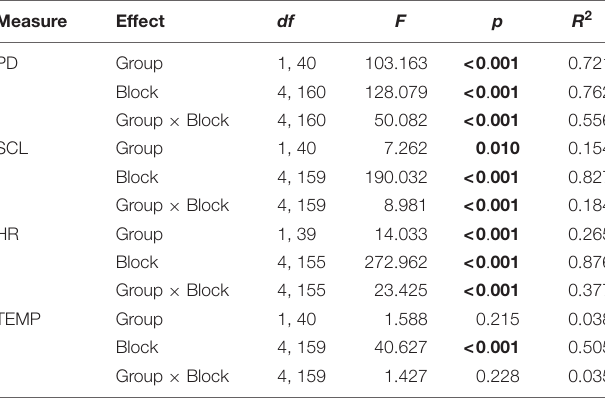
TABLE 2 | Experimental effects induced by exposure to virtual height: summary of linear mixed effect models for psychophysiological measures.